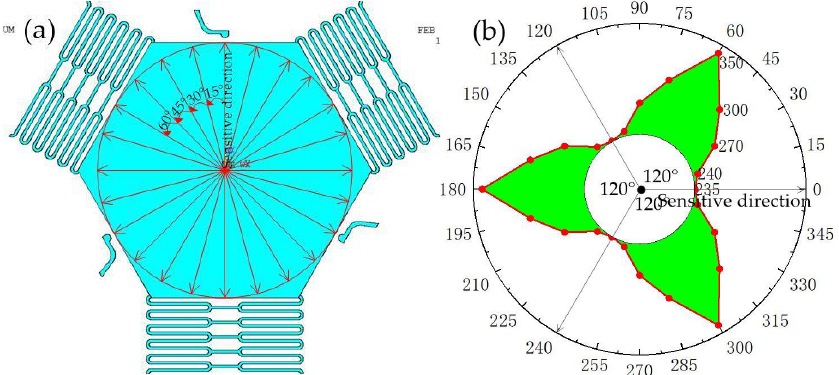
Figure 10. ( a )Threshold distribution diagram of designed three-axis inertial switch., ( b ) the schematic diagram of the directions of applied accelerations.